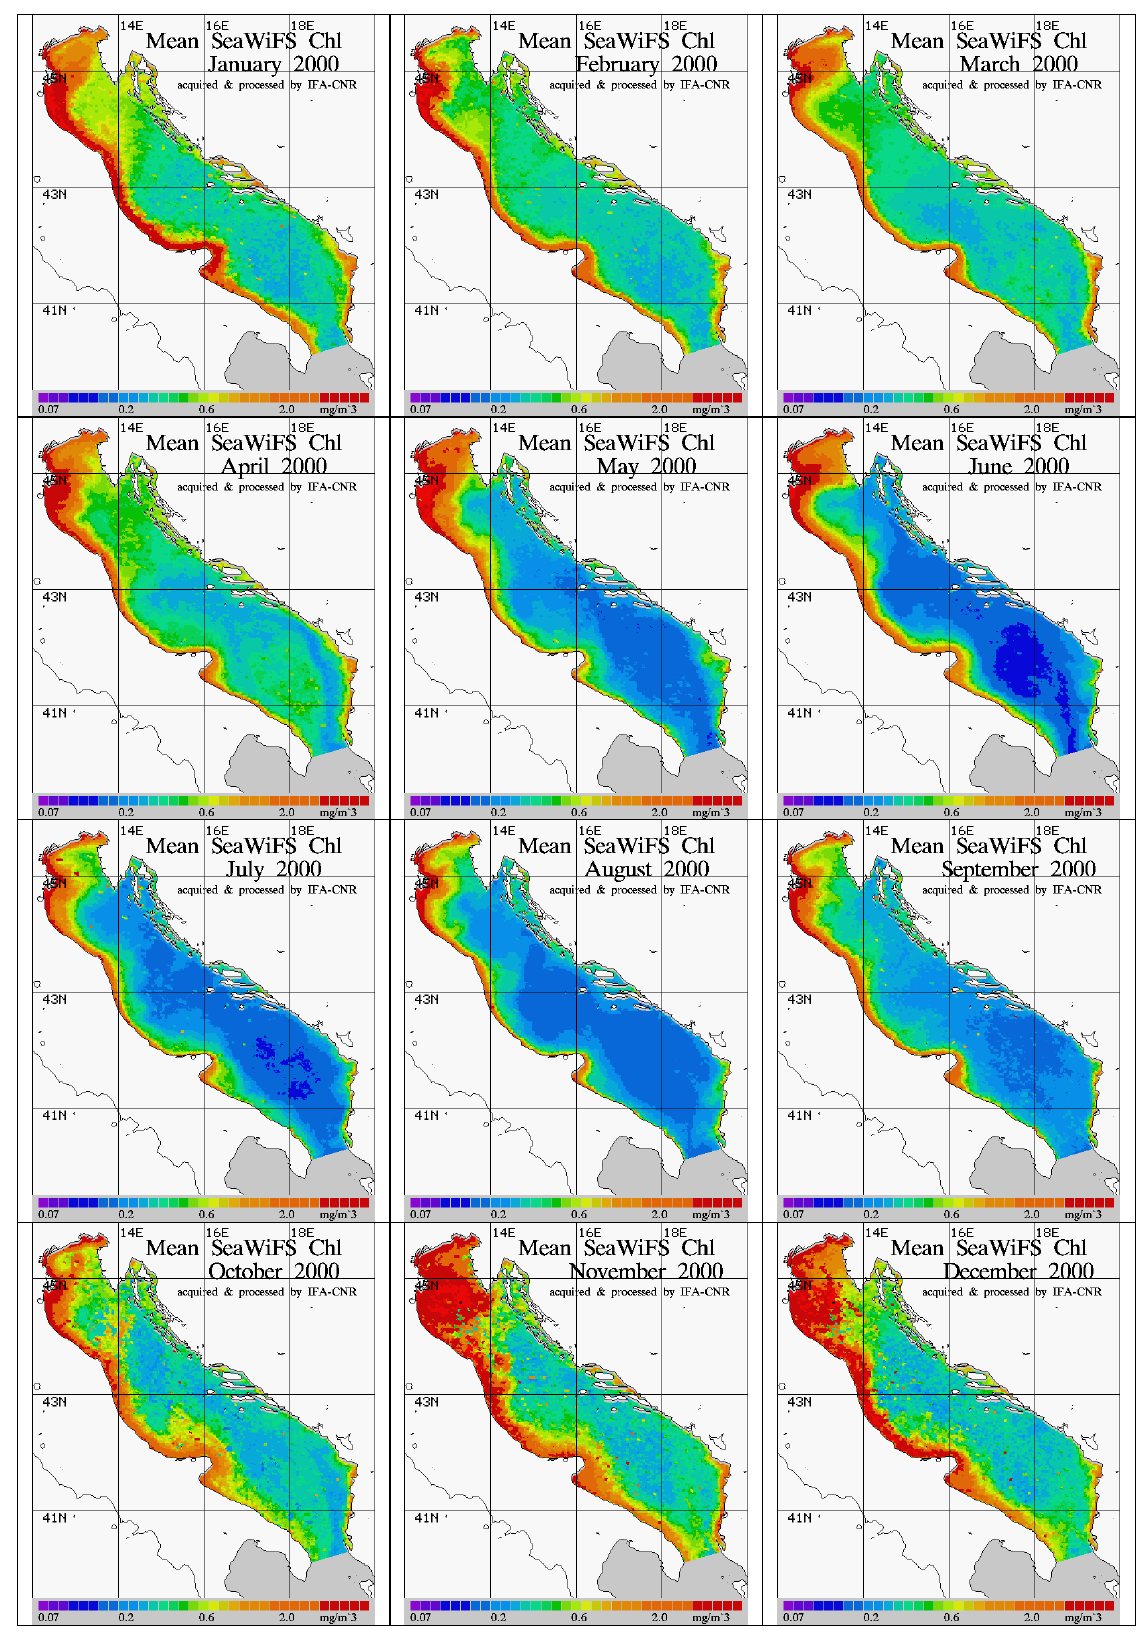
Fig. 3b. Same as Fig. 3a. except for the January – December 2000